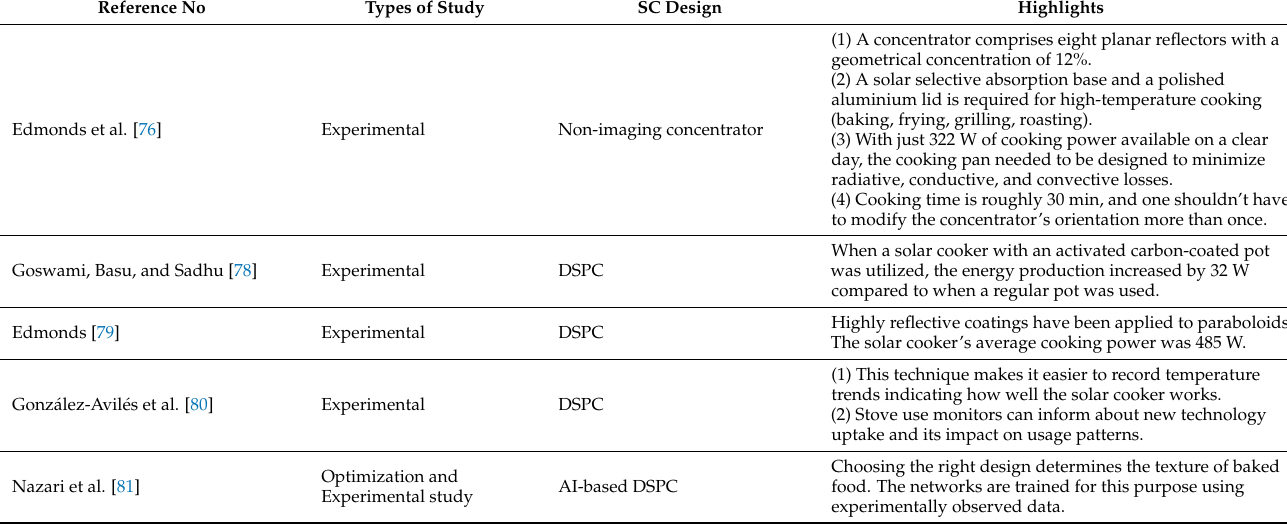
Table 2. Summer of the Concentrating type of solar